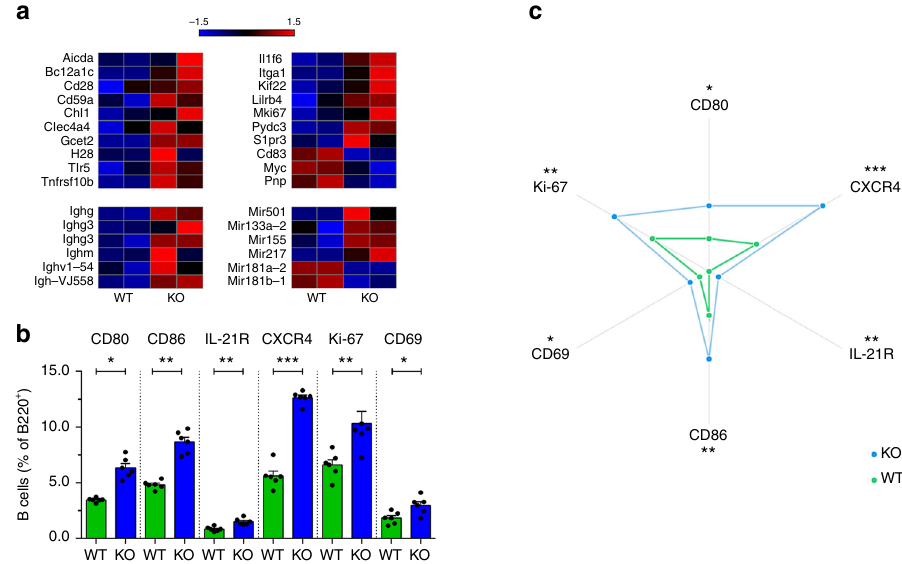
Fig. 2 B cells from Gal-3 KO mice had increased expression of genes related to GC formation and costimulatory molecules. a Heat maps of the expression of selected genes related to the GC reaction determined in B cells from WT and Gal-3 KO mice ( n = 2 for both strains). b Statistical analysis of the frequency of CD80 + , CD86 + , IL-21R + , CXCR4 + , Ki-67 + , and CD69 + B220 + B cells from the spleen of 8-week-old WT and Gal-3 KO mice ( n = 6 for both strains). c Radar plots summarising the B cell phenotype observed in the spleen of Gal-3 KO and WT mice ( n = 6 for both strains). Data are the mean ± s.e. m. * p < 0.05, ** p < 0.005 (unpaired Student ’ s t -test). a Data are representative of two independent experiments. b , c Data are representative of three